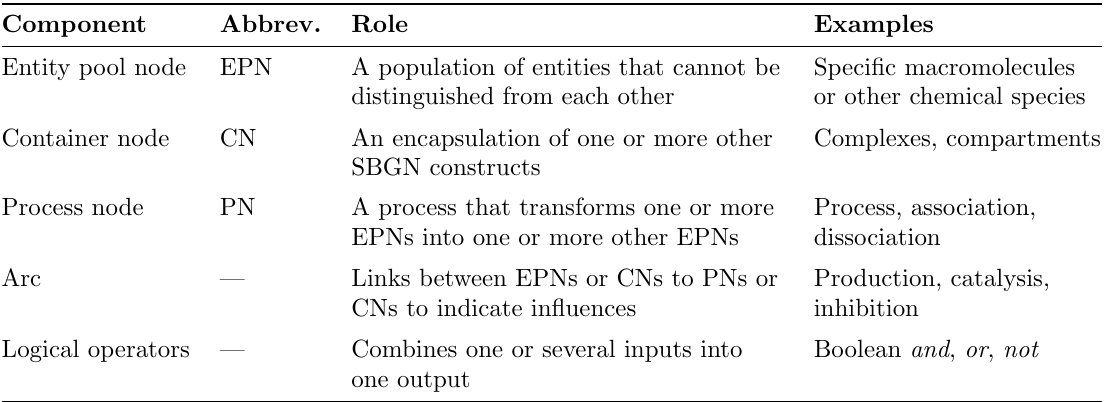
Table 2.1: Summary of Process Description components and their